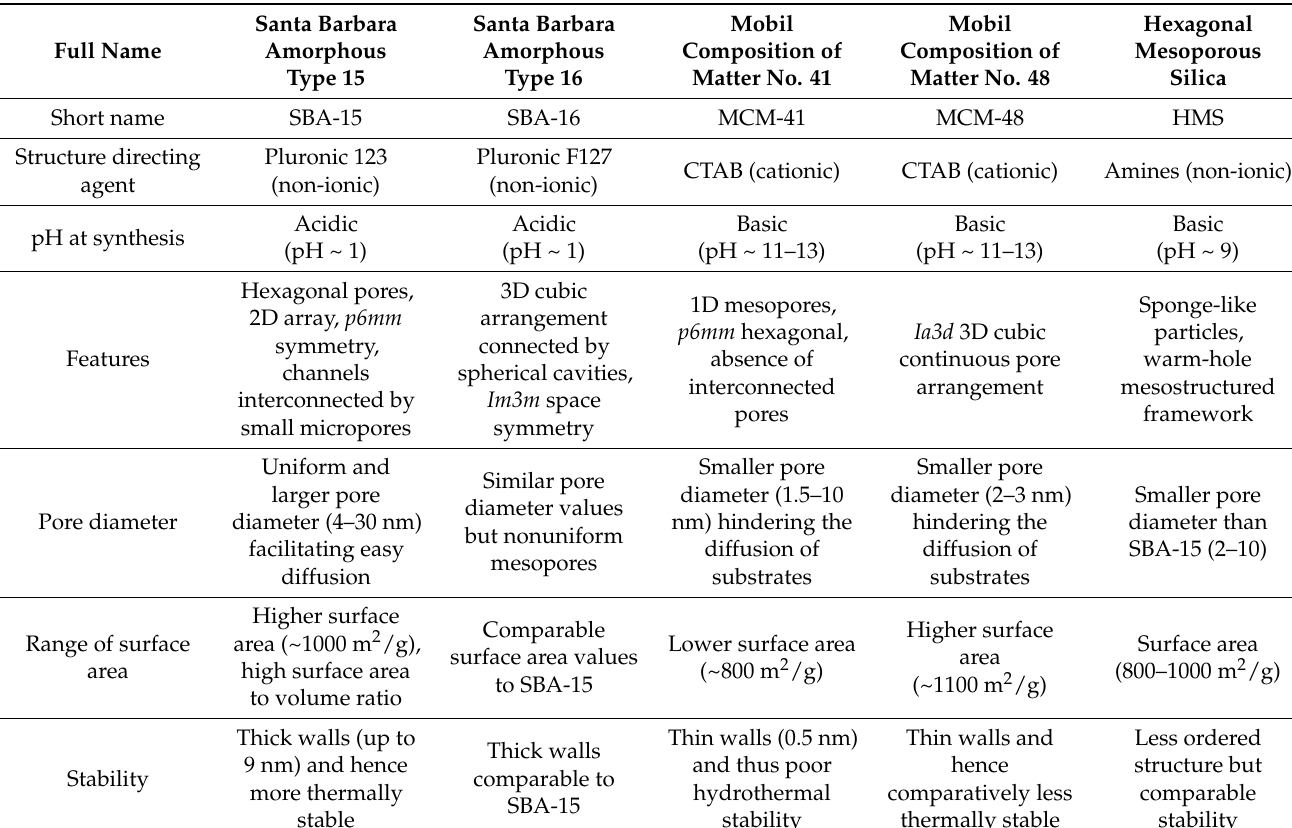
Table 2. Comparison of the properties of various porous silica